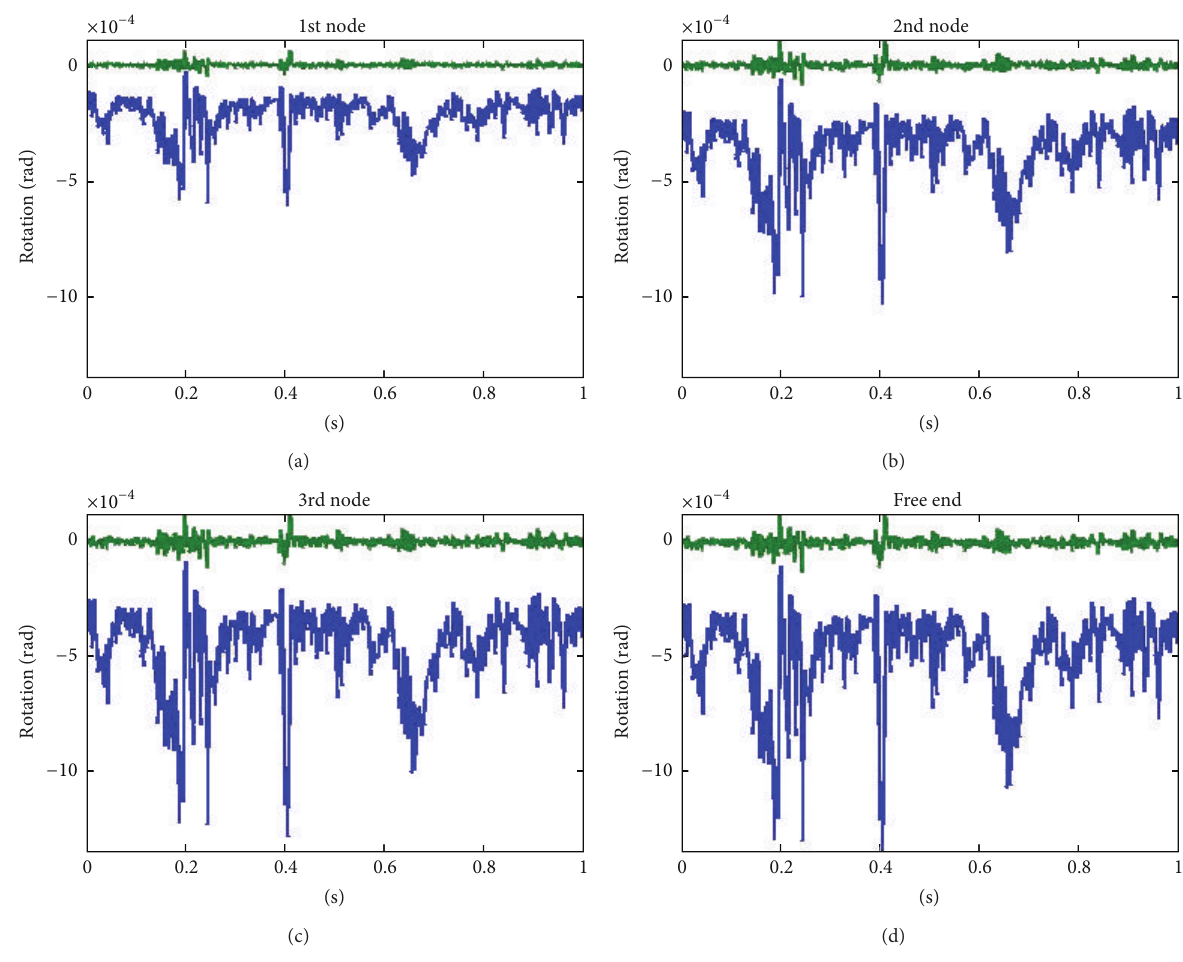
Figure 16: Angle of rotation at all beam nodal points, with and without 𝐻 ∞ control.